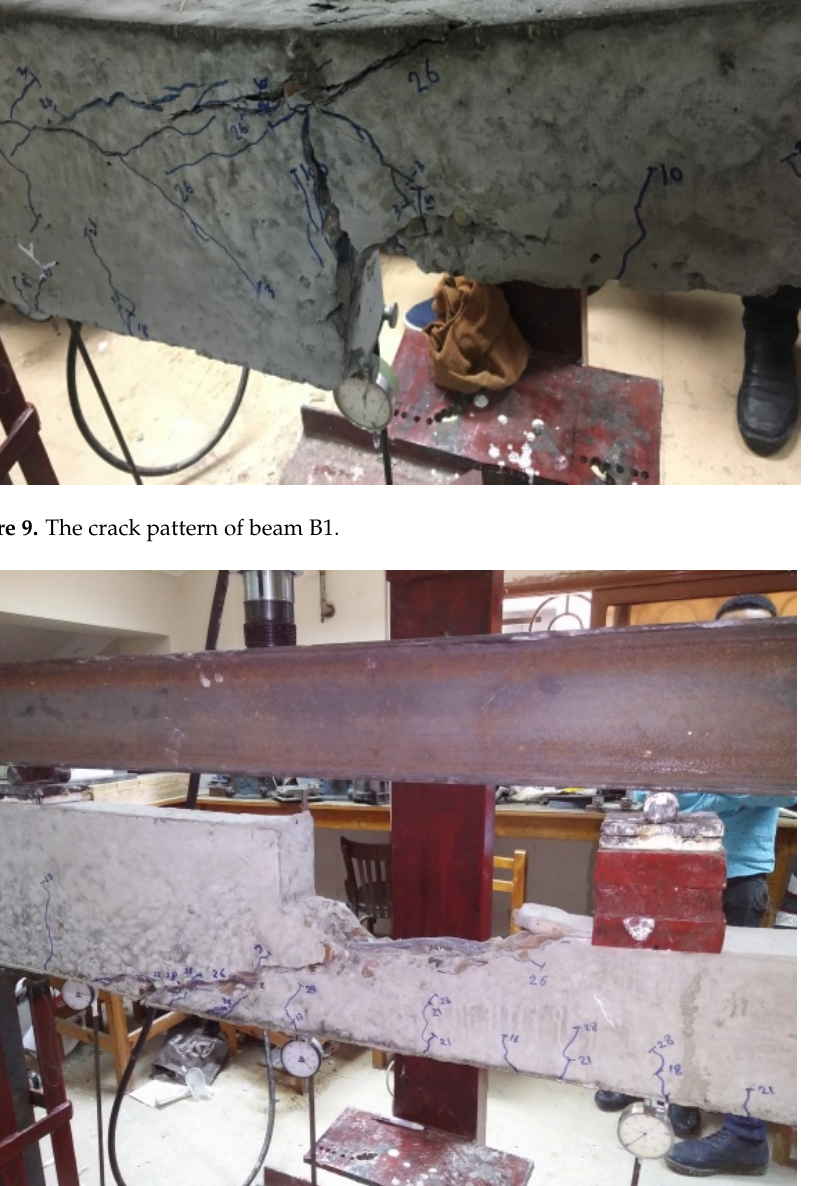
Figure 11. The crack pattern of beam B2.